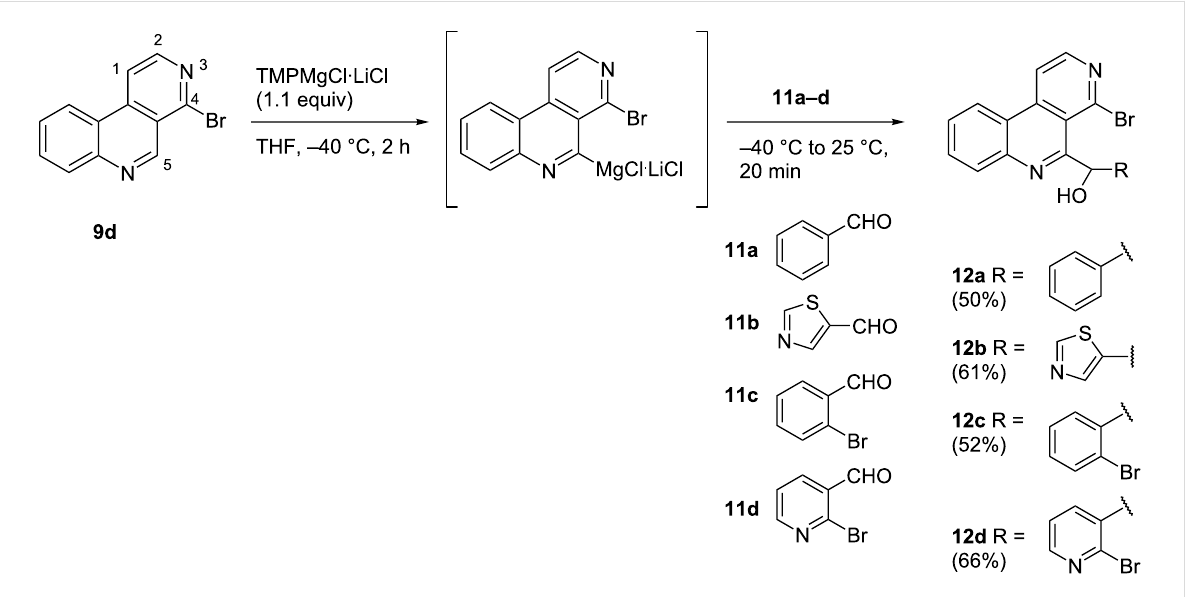
Scheme 1: Regioselective metalation of 4-bromobenzo[ c ][2,7]naphthyridine ( 9d ) and subsequent conversion into secondary alcohols by reaction with (hetero)aromatic